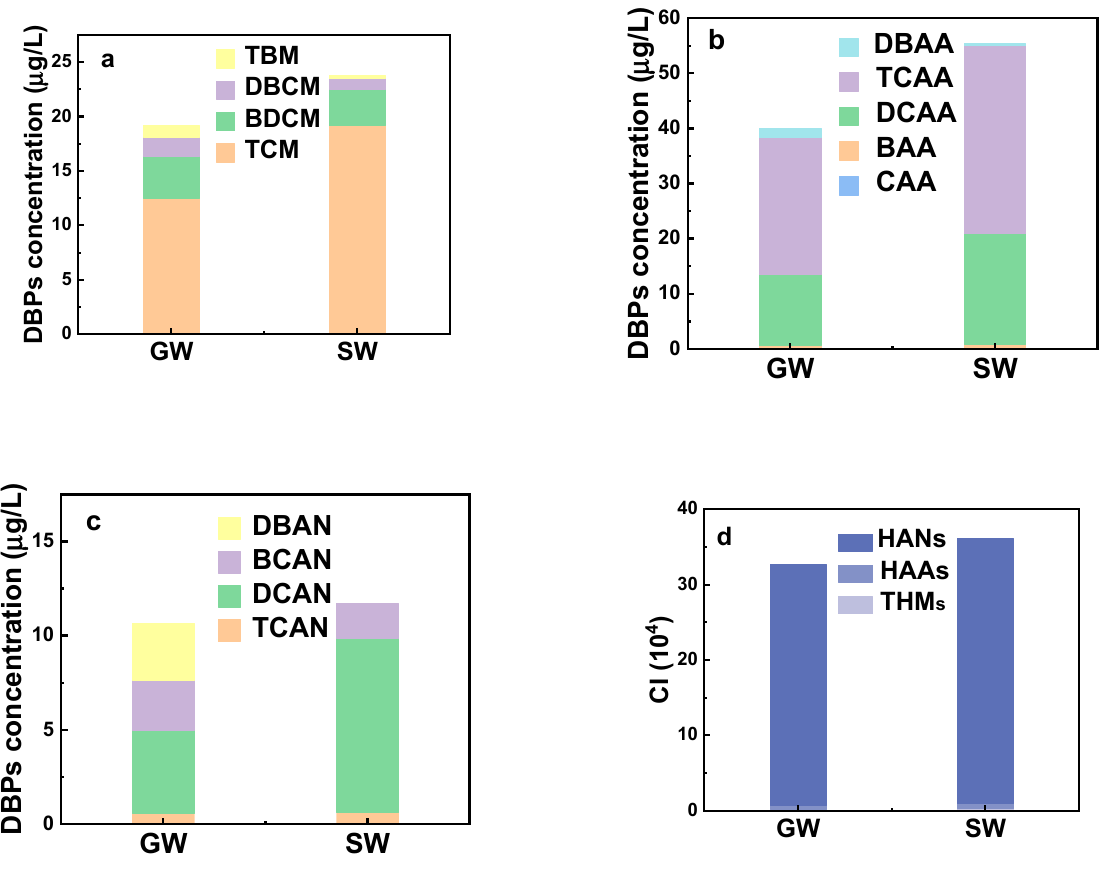
Figure 3. The DBP concentrations in the tap water from different water sources: ( a ) THMs; ( b ) HAAs; ( c ) HANs; ( d ) the cytotoxicity indexes of THMs, HAAs, and HANs. The calculated total mean CI values of the DBPs in GW and SW are shown in Figure